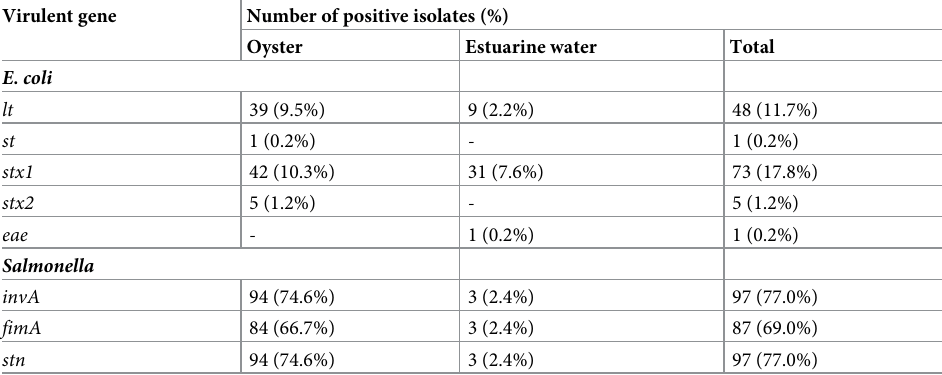
Table 6. Virulence genes of E . coli ( n = 409) and Salmonella ( n = 126) isolated from oysters and estuarine waters.